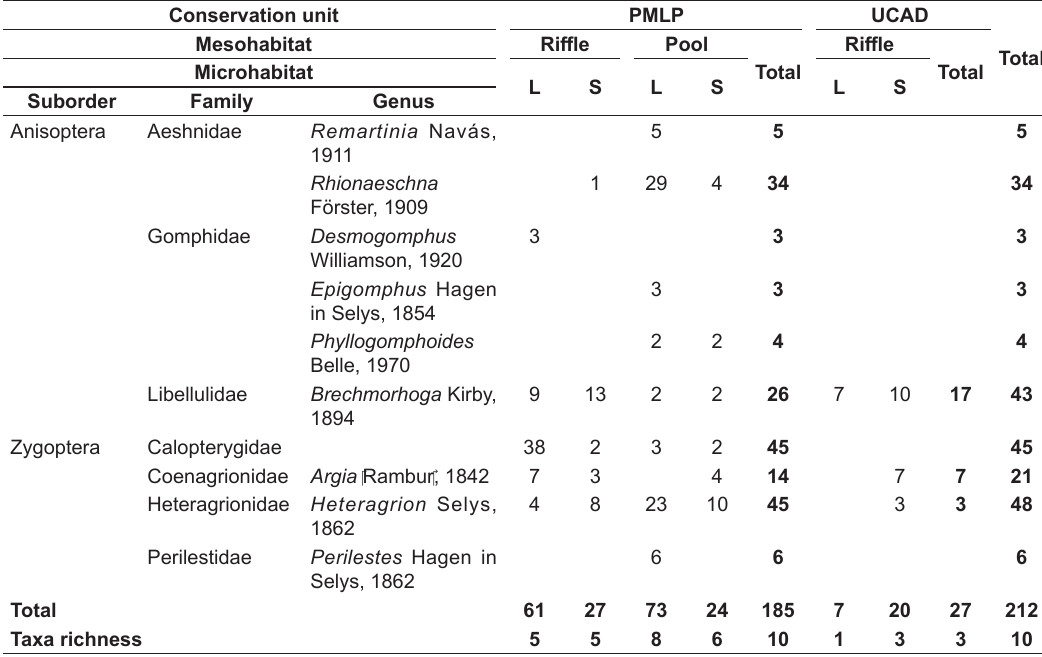
Table 1. Abundance, richness and composition of immature stages of Odonata (Insecta) recorded in meso- and microhabitats in the studied streams in Santa Catarina Island, southern Brazil.